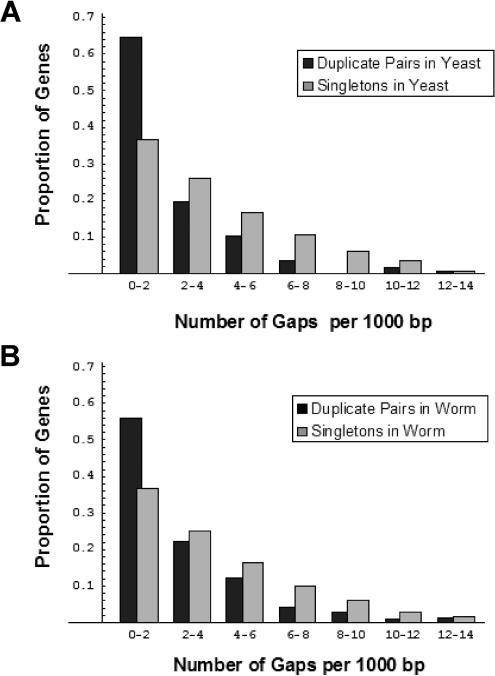
A Comparison of the Rate of Structural Evolution for Duplicate and Singleton GenesFor each representative pair, the number of gaps per aligned nucleotide was calculated. For both S. cerevisiae (A) and C. elegans (B), representative pairs of duplicates have significantly fewer insertions per basepair than representative pairs for singletons (Mann–Whitney U test, p < 0.0001 for both).